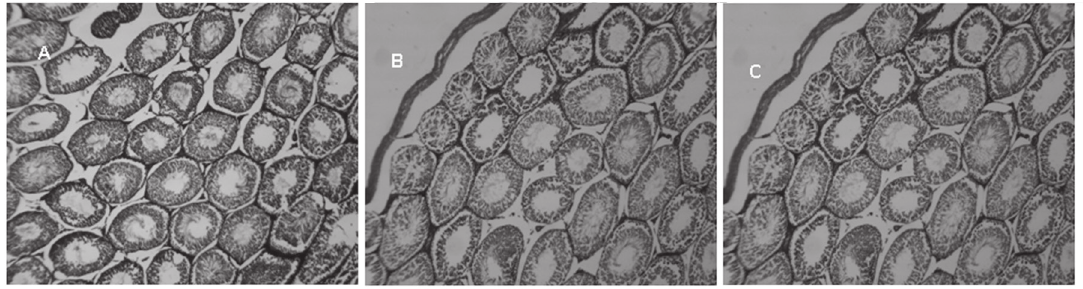
Figure 3 - Histology of testicls in rats experimentally infected with Trypanosoma evansi . Seminiferous tubules of healthy animals (A) compared to rats infected at days 5 (B) and 15 (C) post-infection. It can be seen in testis animals infected with T. evansi a marked reduction of the thickness and an increase in the degeneration of the seminiferous epithelium as well as a reduction in the number of sperm in the lumen of the seminiferous tubule. Bar: 20µm.